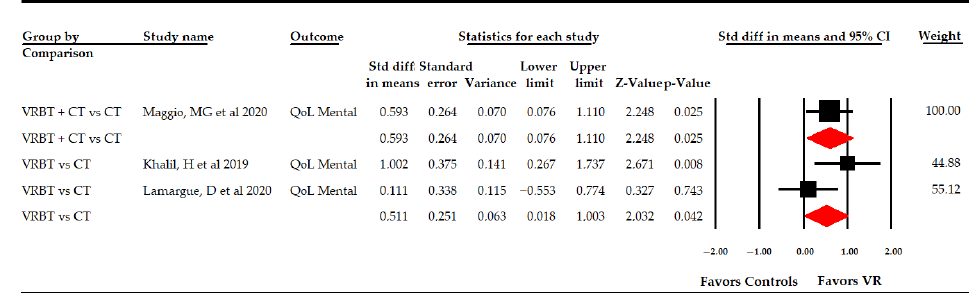
Figure 9. Subgroup Analysis of the Effect of Virtual Reality on the Mental Dimension of Quality of Life According to Specific Comparisons.